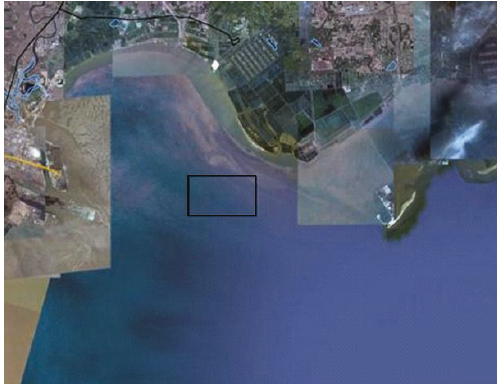
Figure 6: The area at Bo Sea for geomagnetic surveying.